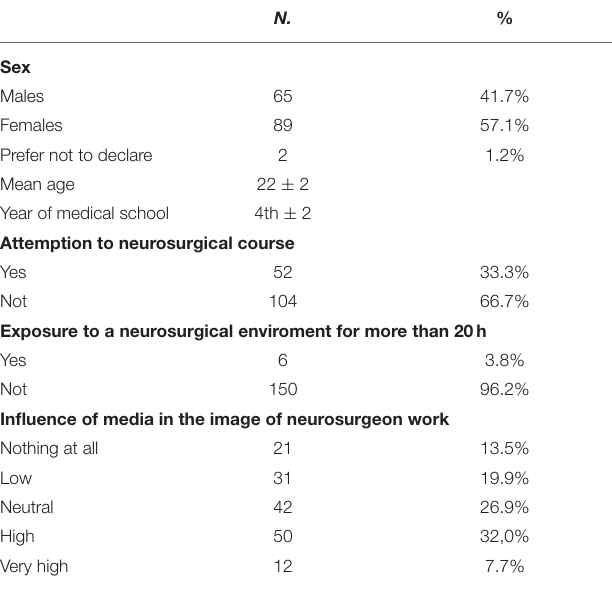
TABLE 1 | Features of the participants to the